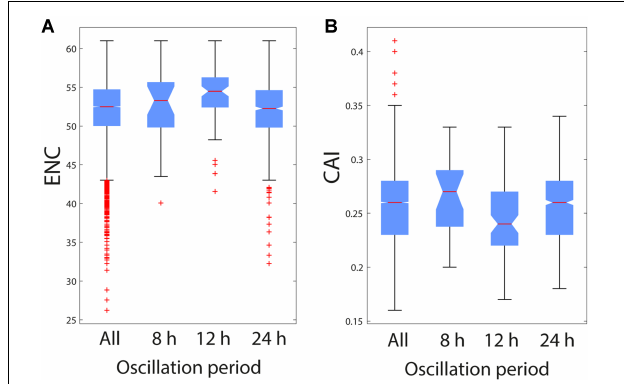
FIGURE 2 | Effective Number of Codons (ENC) and Codon Adaptation Index (CAI) in the three oscillating gene subsets and the global mouse transcriptome. (A) Box plots of ENC values calculated for all selected mouse transcript sequences (All) and the three oscillating gene subsets (8, 12, and 24 h). Selection was carried out according to the GC content (see section “Materials and Methods” for details). (B) Box plots of CAI values calculated for all selected mouse transcript sequences and the three oscillating gene subsets.